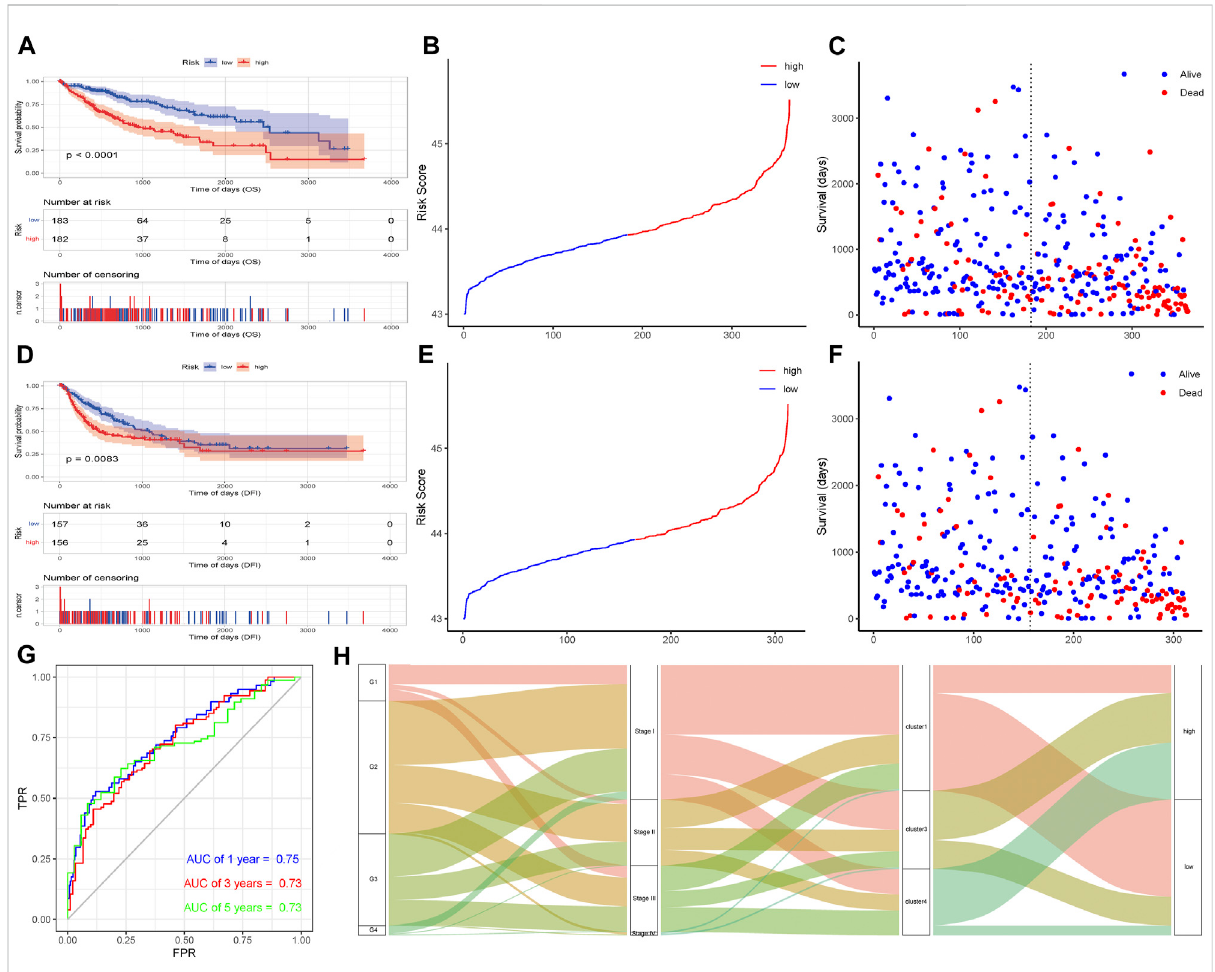
FIGURE 8 Effectiveness veri fi cation of a risk model based on PSI events. (A) Build model KM curve veri fi cation based on OS-based lasso regression. (B) Curve graph of risk scores of all samples based on OS. (C) Scatter plot of survival time of all samples based on OS. (D) Build model KM based on lasso regression of DFICurve veri fi cation. (E) Curve graphof riskscores ofall samplesbased on DFI. (F) Scatter plotof survival time ofall samplesbased on DFI. (G) Time-based ROC curve. (H) Sankey diagram of clinical traits, risk grouping and alternative splicing